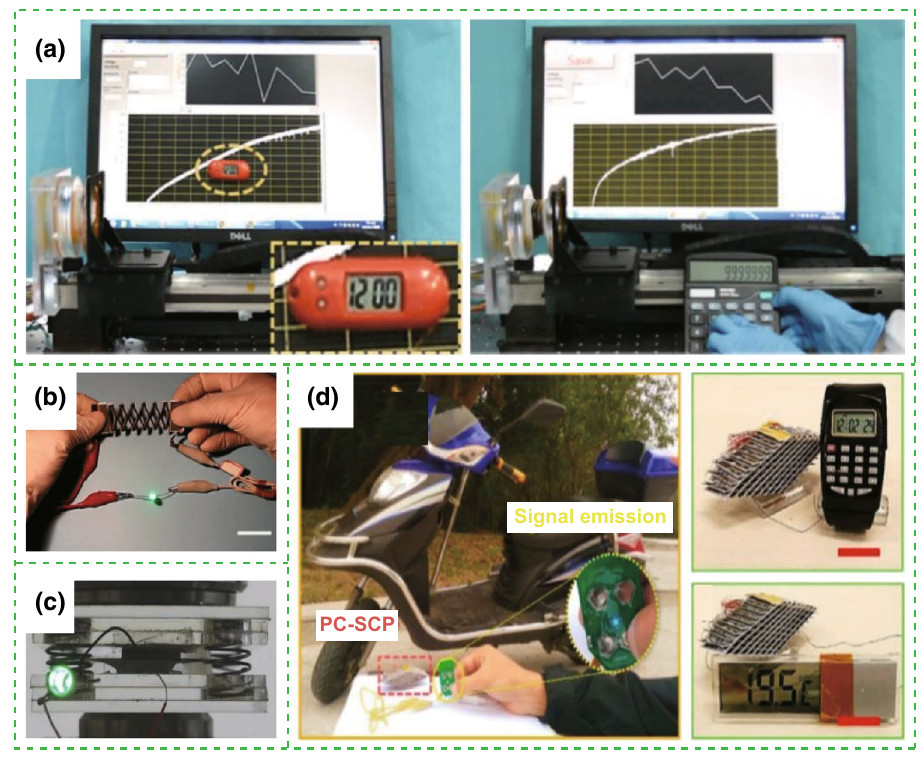
Fig. 15 a Photograph of the self‑charging power system powering an electronic watch and a calculator at 5 Hz. Reprinted with permission from Ref. [24]. b Photograph of the integrated KP‑SC (6 units, 3 devices in series) lighting up a single commercial green LED under cycling stretch‑ ing movement. Reprinted with permission from Ref. [26]. c Photograph of a green LED that can be lighted up by the convoluted power device as an SLB. Reprinted with permission from Ref. [27]. d Demonstration of a self‑powered wireless remote control by incorporating a PC‑SCPU, digital electric watch and temperature meter driven by manually tapping the PC‑SCPU. Reprinted with permission from Ref.